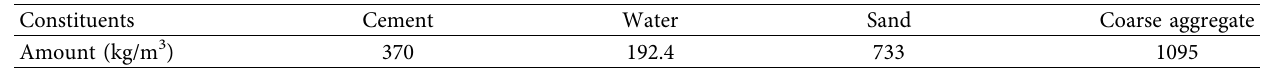
Figure 2: Scoria: (a) before grinding; (b) scoria powder. Table 3: Proportions of concrete ingredients per cubic meter (kg/m 3 ).